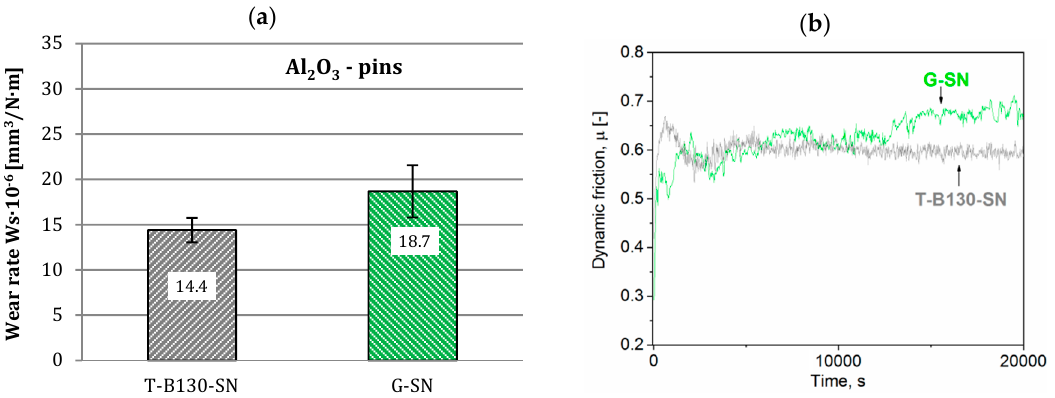
Figure 16. Wear rates ( a ) and dynamic friction ( b ) values for Vancron 40 steel after G-SN and T-B130-SN; Al 2 O 3 pins as counterbodies were used.